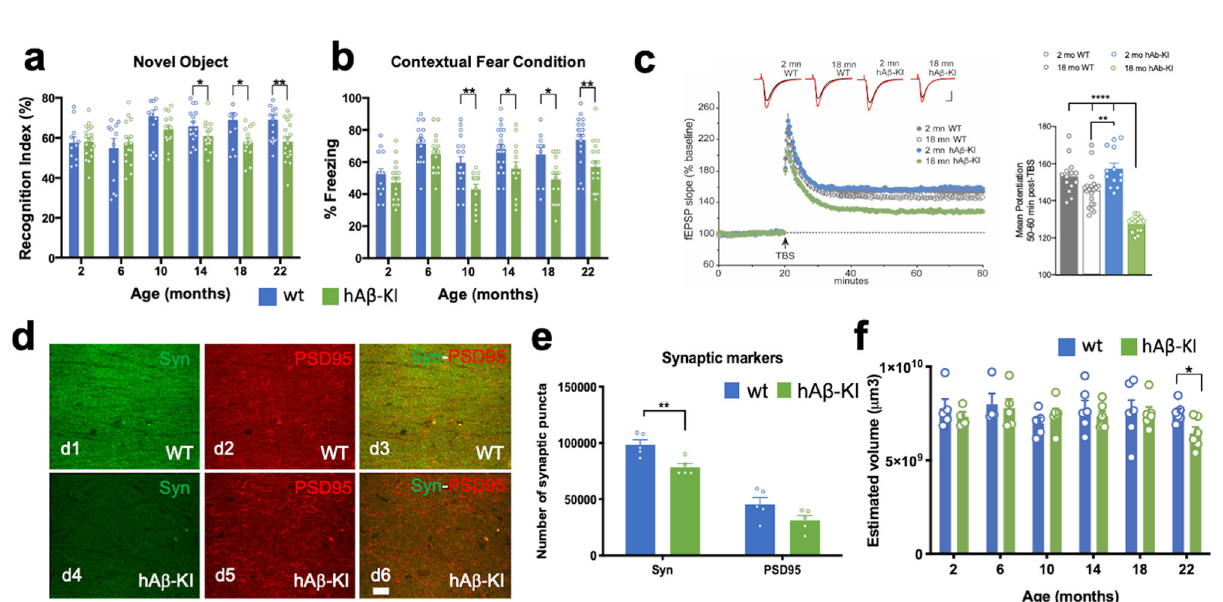
Fig. 5 Phenotypic alterations in CNS of hA β -KI mice. a hA β -KI (green) mice showed cortical de fi cits at 14, 18 and 22 months compared to WT (blue mice) (unpaired, two-tailed t -test, 14 mo * p = 0.0381, 18 mo * p = 0.0131 and 22 mo ** p = 0.0024) (WT 2 mo n = 11, 6 mo n = 13, 10 mo and 14 mo n = 16, 18 mo n = 12, and 22 mo n = 20; hA β -KI 2 mo, 18 mo and 22 mo n = 18, 6 mo n = 16, 10 mo n = 13 and 14 mo n = 14). b Hippocampal de fi cits were also observed in hA β -KI (green) mice at 10, 14, 18 and 22 months compared to WT (blue) mice (unpaired, two-tailed t -test, 10 mo ** p = 0.0037, 14 mo * p = 0.0239, 18 mo * p = 0.0112 and 22 mo ** p = 0.0020) (WT 2 mo n = 15, 6 mo n = 14, 10 mo n = 18, 14 mo n = 20, 18 mo n = 12, 22 mo n = 19; hA β -KI 2 mo and 22 mo n = 18, 6 mo and 18 mo n = 15, 10 mo n = 13 and 14 mo n = 14). c Acute hippocampal slices were examined for changes in synaptic plasticity in 2 and 18- month-old WT (gray = 2 mo and white = 18 mo) and hA β -KI (blue = 2 mo and green = 18 mo) mice. Theta burst induced LTP was impaired in slices from hA β -KI mice (2 mo and 18 mo n = 13 slices) relative to aged-matched WT controls (2 mo n = 14 slices, 18 mo n = 20 slices). Synaptic responses in control pathway remained stable (no theta stimulation) throughout the recording session. Insets show fi eld synaptic responses collected during baseline (black line) and 1 h after theta burst stimulation (red line). Scale: 1 mV/5 ms. Mean (±SEM) percent potentiation 50 – 60 min post-TBS was markedly depressed in slices from hA β -KI mice relative to WT controls (two-way ANOVA, major effect in interaction F 1,56 = 22.46 and age factor F 1,56 = 64.52, Tukey ’ s post hoc test, ** p < 0.01 and **** p < 0.0001). d , e Confocal images of synaptic puncta stained with synaptophysin (green) and PSD-95 (red) antibodies, shows a signi fi cant decrease at presynaptic level in hA β -KI (d4 – d6; green) versus WT (d1 – d3; blue) mice at 18 months (unpaired, two-tailed t -test, ** p = 0.0062) ( n = 5/genotype). f Cavalieri method shows signi fi cant differences in hippocampal volume between WT (blue) and hA β -KI (green) mice at 22 months of age (unpaired, two-tailed t -test, * p = 0.0199; n = 4 in 6 mo-WT and 2 mo-hA β -KI, n = 5 in 2 mo-WT, 10 mo-WT and 6 mo-hA β -KI, n = 6 in 14 mo, 18 mo, 22 mo-WT and 10 mo, 14 mo, 18 mo and 22 mo-hA β -KI). Data are presented as mean values ± SEM. Scale bar: 10 μ m (d1 –